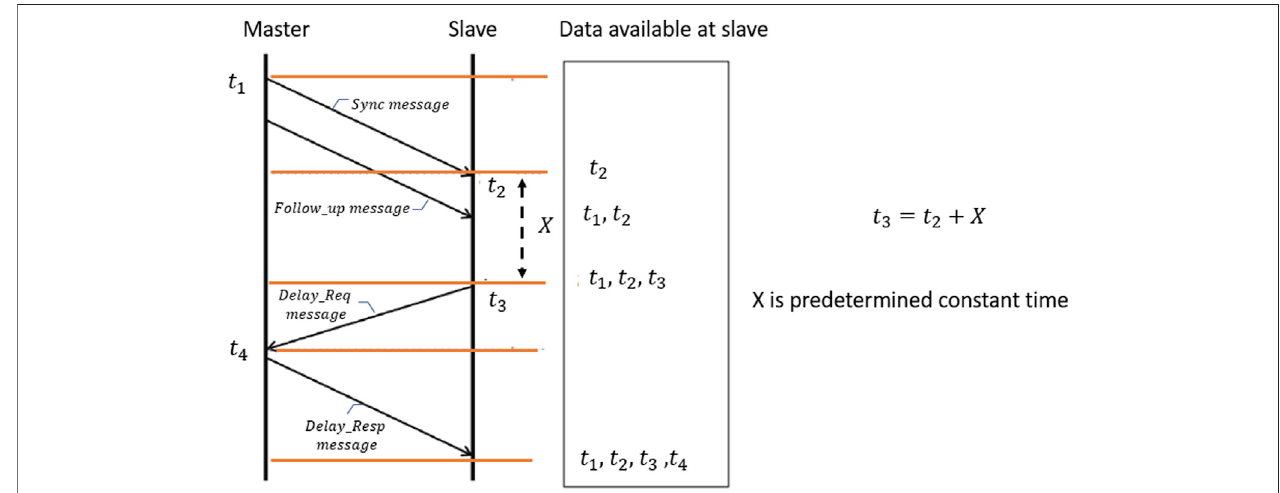
FIGURE 1 | PTP messaging timing